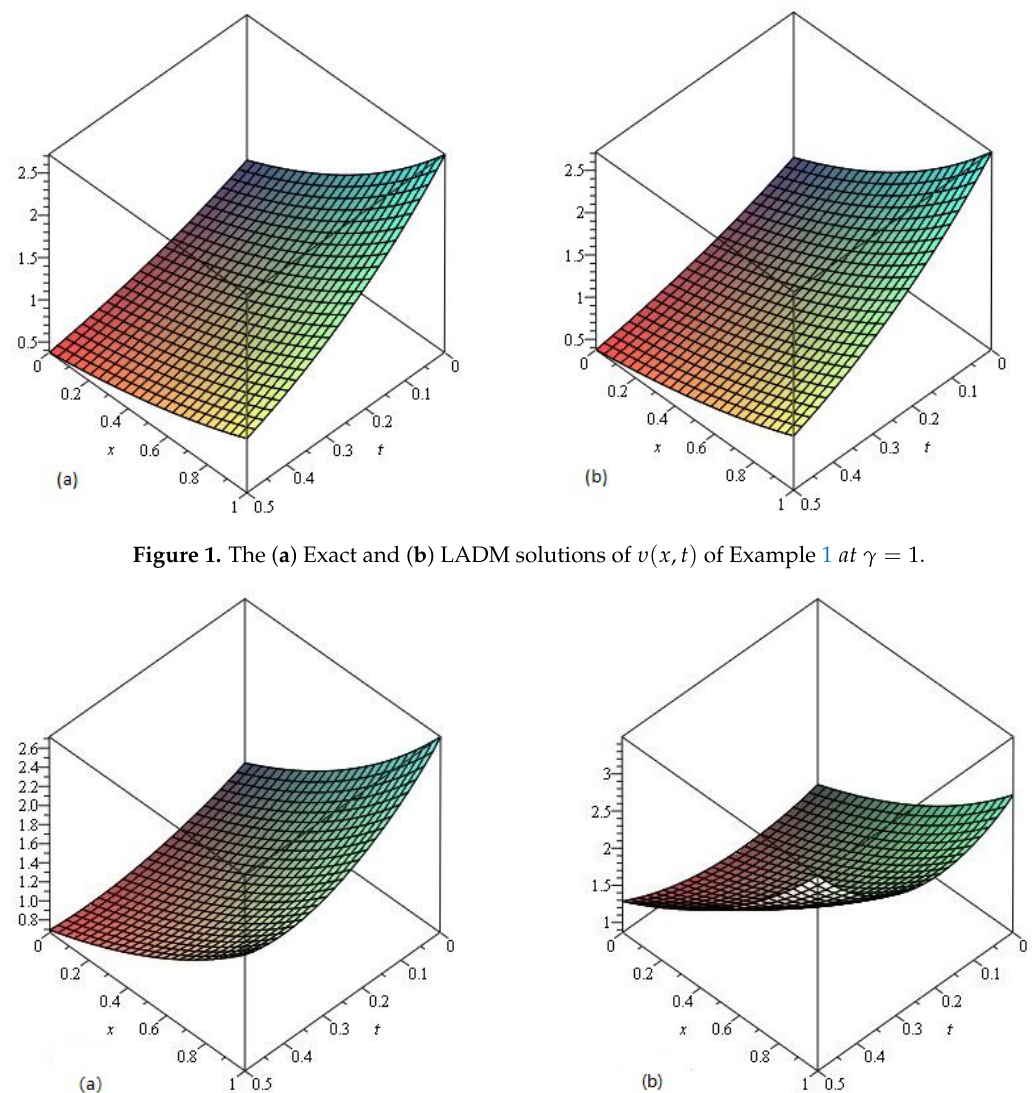
Figure 2. The LADM solution of υ ( x , t ) of Example 1 at ( a ) γ = 0.75 and ( b ) at γ =